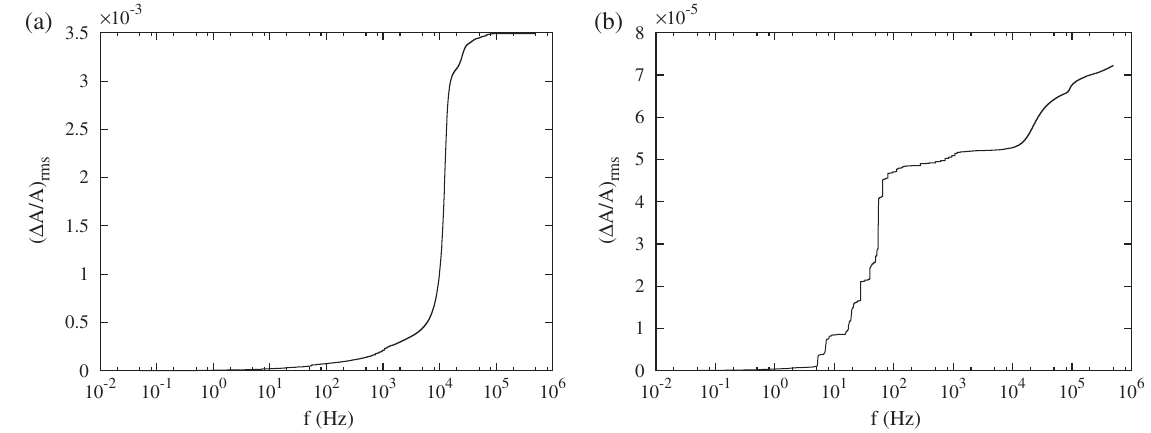
FIG. 9. Integrated magnitude spectra of relative amplitude error of the SEL with (a) phase controller activated but without amplitude feedback and (b) with both feedback loops closed. Parameters have been optimized for small residual errors with both controllers